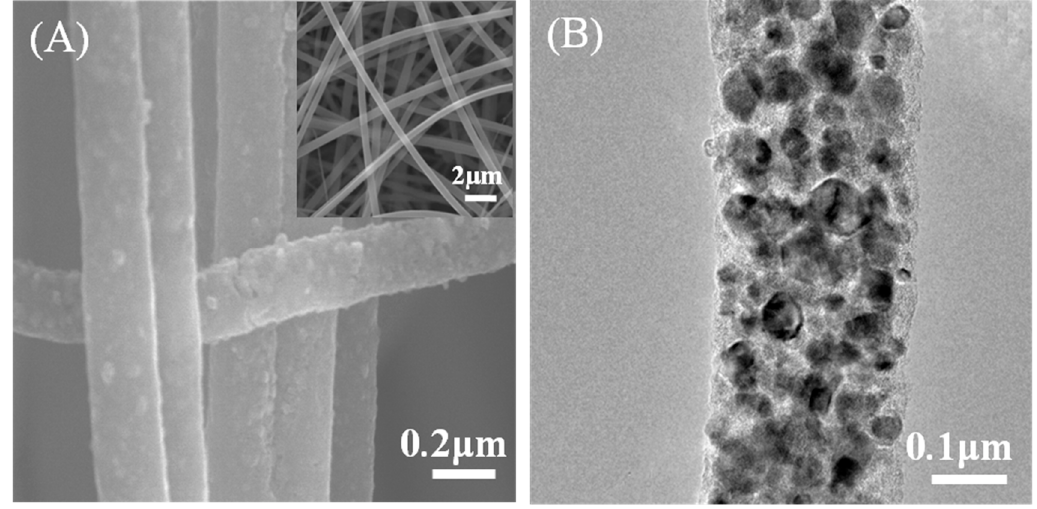
Figure 1. SEM ( A ) and TEM ( B ) images of TiC/C; Inset was the SEM image of CNFs.